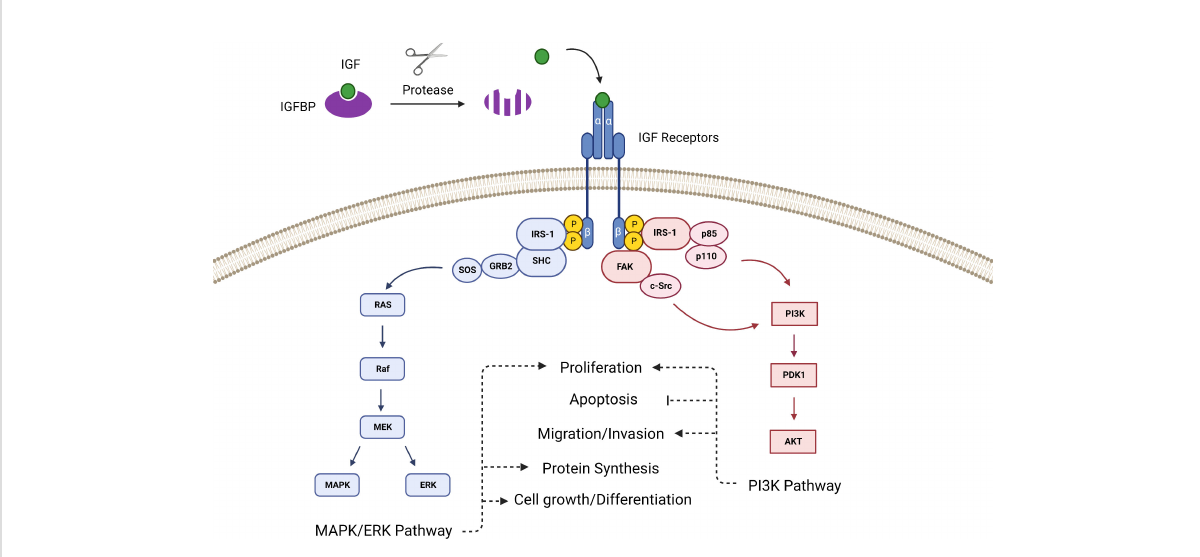
FIGURE 1 The canonical IGF signaling pathway is activated after proteases cleave the IGFBPs to release IGF, which then binds with the IGF receptor to activate pathways that control proliferation, survival and apoptosis, angiogenesis, differentiation, and